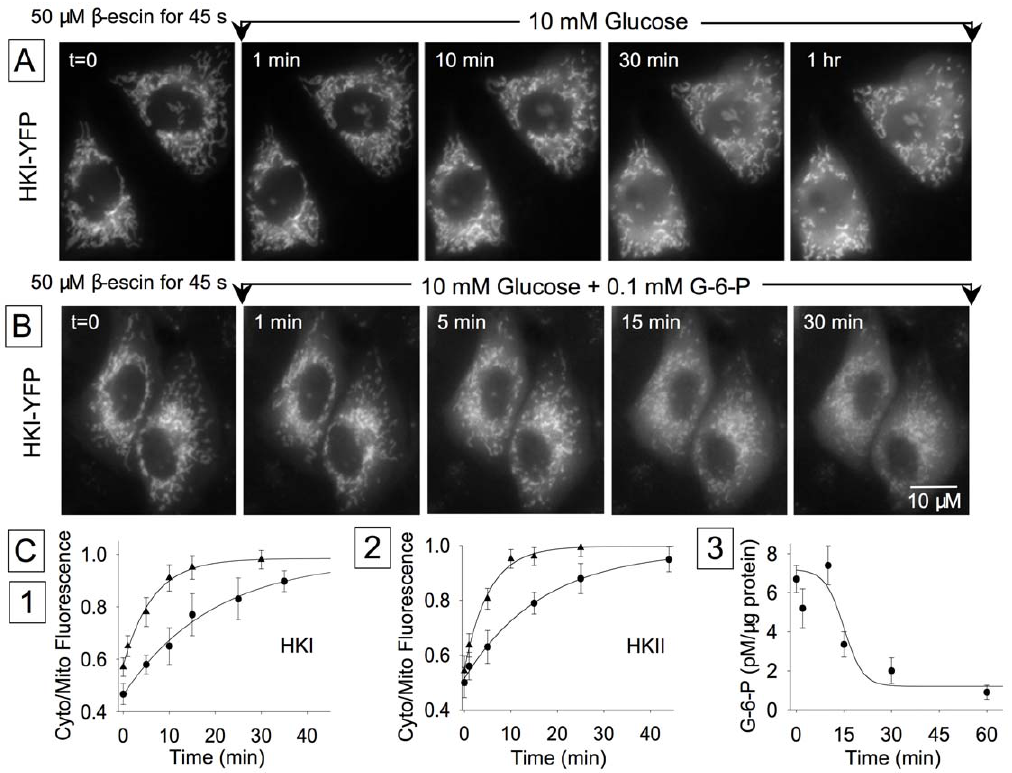
Figure 9. HKs dissociation from mitochondria in permeabilized cells. Panels A and B illustrate the spontaneous dissociation of HKI-YFP in the absence and presence of G-6-P, respectively, after cell membrane permeabilization with 50 m M b -escin. Panel C1 and C2 show that HKI and HKII dissociate for mitochondria at very similar rates, and G-6-P increases these rates by approximately 4 fold (20 min vs. 5 min). The triangles represent measurements obtained with G-6-P (100 nM) and the circles are for values obtained in the absence of G-6-P. Panel C3 shows the change in intracellular G-6-P levels following glucose removal.